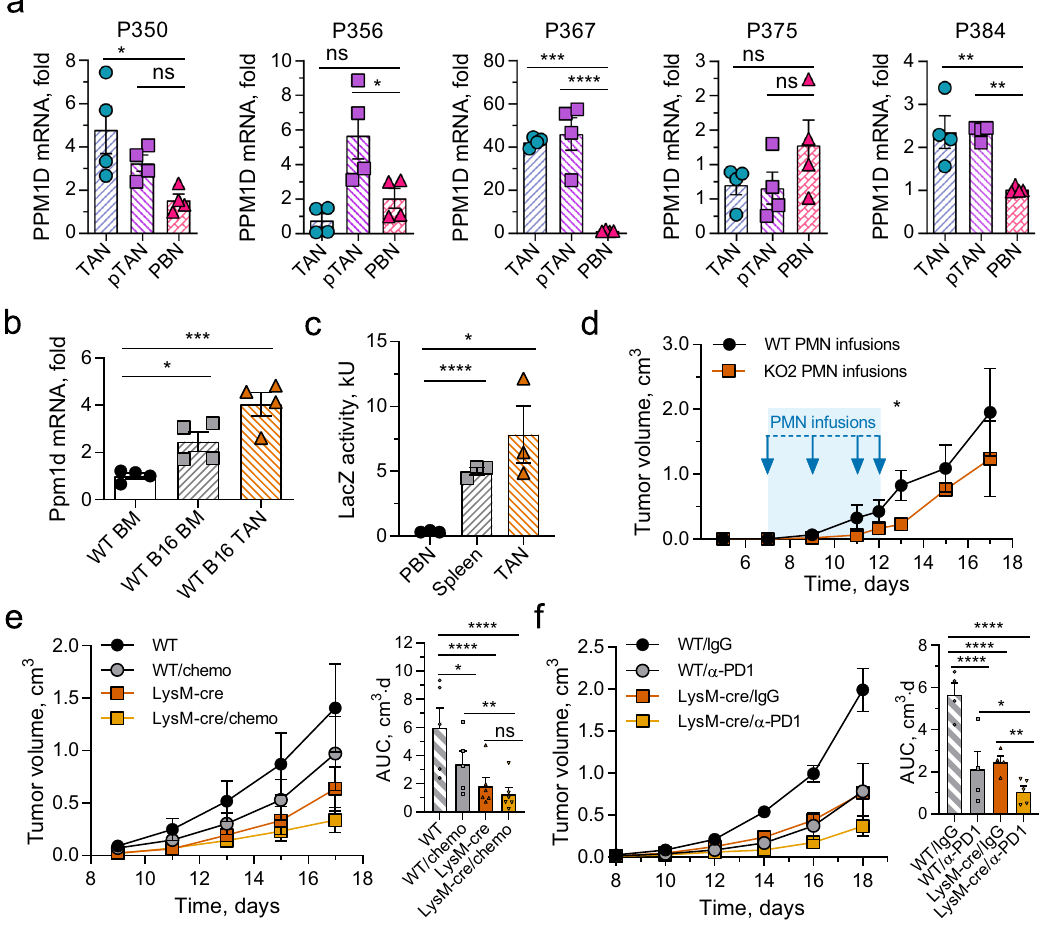
Fig. 6 Tumor-associated neutrophils express high levels of Wip1 and inactivation of Wip1 in myeloid cells enhances antitumor responses. a Relative PPM1D mRNA levels in neutrophils isolated from surgically resected tumors (TAN), peri-tumor tissues (pTAN), or peripheral blood (PBN) from fi ve patients with Stage I – II lung cancer ( n = 5 different patients examined over 4 individual experiments). b Relative Ppm1d mRNA levels in neutrophils isolated from bone marrow of naive (WT BM) or B16 tumor-bearing (WT BM B16) Ppm1d + / + mice and from B16 tumors engrafted in Ppm1d + / + mice (WT TAN B16) ( n = 4 each condition). c Flow cytometry analysis of LacZ activity in neutrophils isolated from peripheral blood (PBN), spleen (Spleen), or B16 tumors (TAN) of tumor-bearing Ppm1d promoter LacZ reporter mice ( Ppm1d + /KO2 ) ( n = 3 each condition). d Growth of B16 melanoma tumors in WT mice treated on days 7, 9, 11, and 12 (blue arrows) with injection of neutralizing anti-Ly6G + antibodies to deplete host neutrophils and infusion of Ppm1d + / + (WT PMN) or Ppm1d KO2/KO2 (KO PMN) donor neutrophils ( n = 4 each genotype). e Tumor volume (left) and AUC (right) for growth of B16 F10 tumors in Ppm1d + / + (WT, n = 5 each condition) and Ppm1d LysM-Cre (LysM-Cre, n = 6 each condition) mice without and with oxaliplatin + 5FU combination chemotherapy (chemo). f Tumor volume (left) and AUC (right) for growth of B16 F10 tumors in Ppm1d + / + (WT, n = 4 each condition) and Ppm1d LysM-Cre (LysM-Cre, n = 4, untreated, n = 5 α -PD1) mice without and with anti-PD1 antibody treatment ( α -PD1). Data are depicted as means± SEM. One-way ANOVA with Dunnett ’ s ( a – c ) or Sidak ’ s ( e , f ) multiple- comparison test or Student ’ s t test (two-tailed) ( d , day 13): * p < 0.05; ** p < 0.01; *** p < 0.001; **** p < 0.0001 (one representative experiment out of two is shown for panel d and out of three is shown for panel e , f ). Source data are provided as a Source Excel Data fi